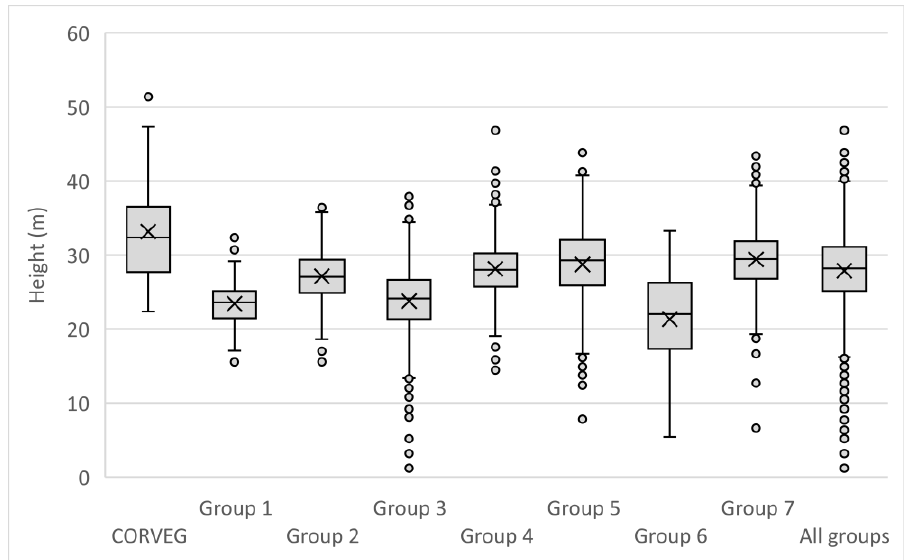
Figure 6. Canopy height variations within the seven Koala Coast intra-subregional groups. Groups 2, 4, 5, and 7 are generally taller than Groups 1, 3, and 6. Heights below 15 m are typically near the polygon group edges and can be attributed to mapping errors or edge disturbances. Table 8. Variations in the canopy heights for seven geographically distinct intra-subregional groups within the Koala Coast regional group. Compared to CORVEG, several groups have negatively skewed distributions and lower variances.